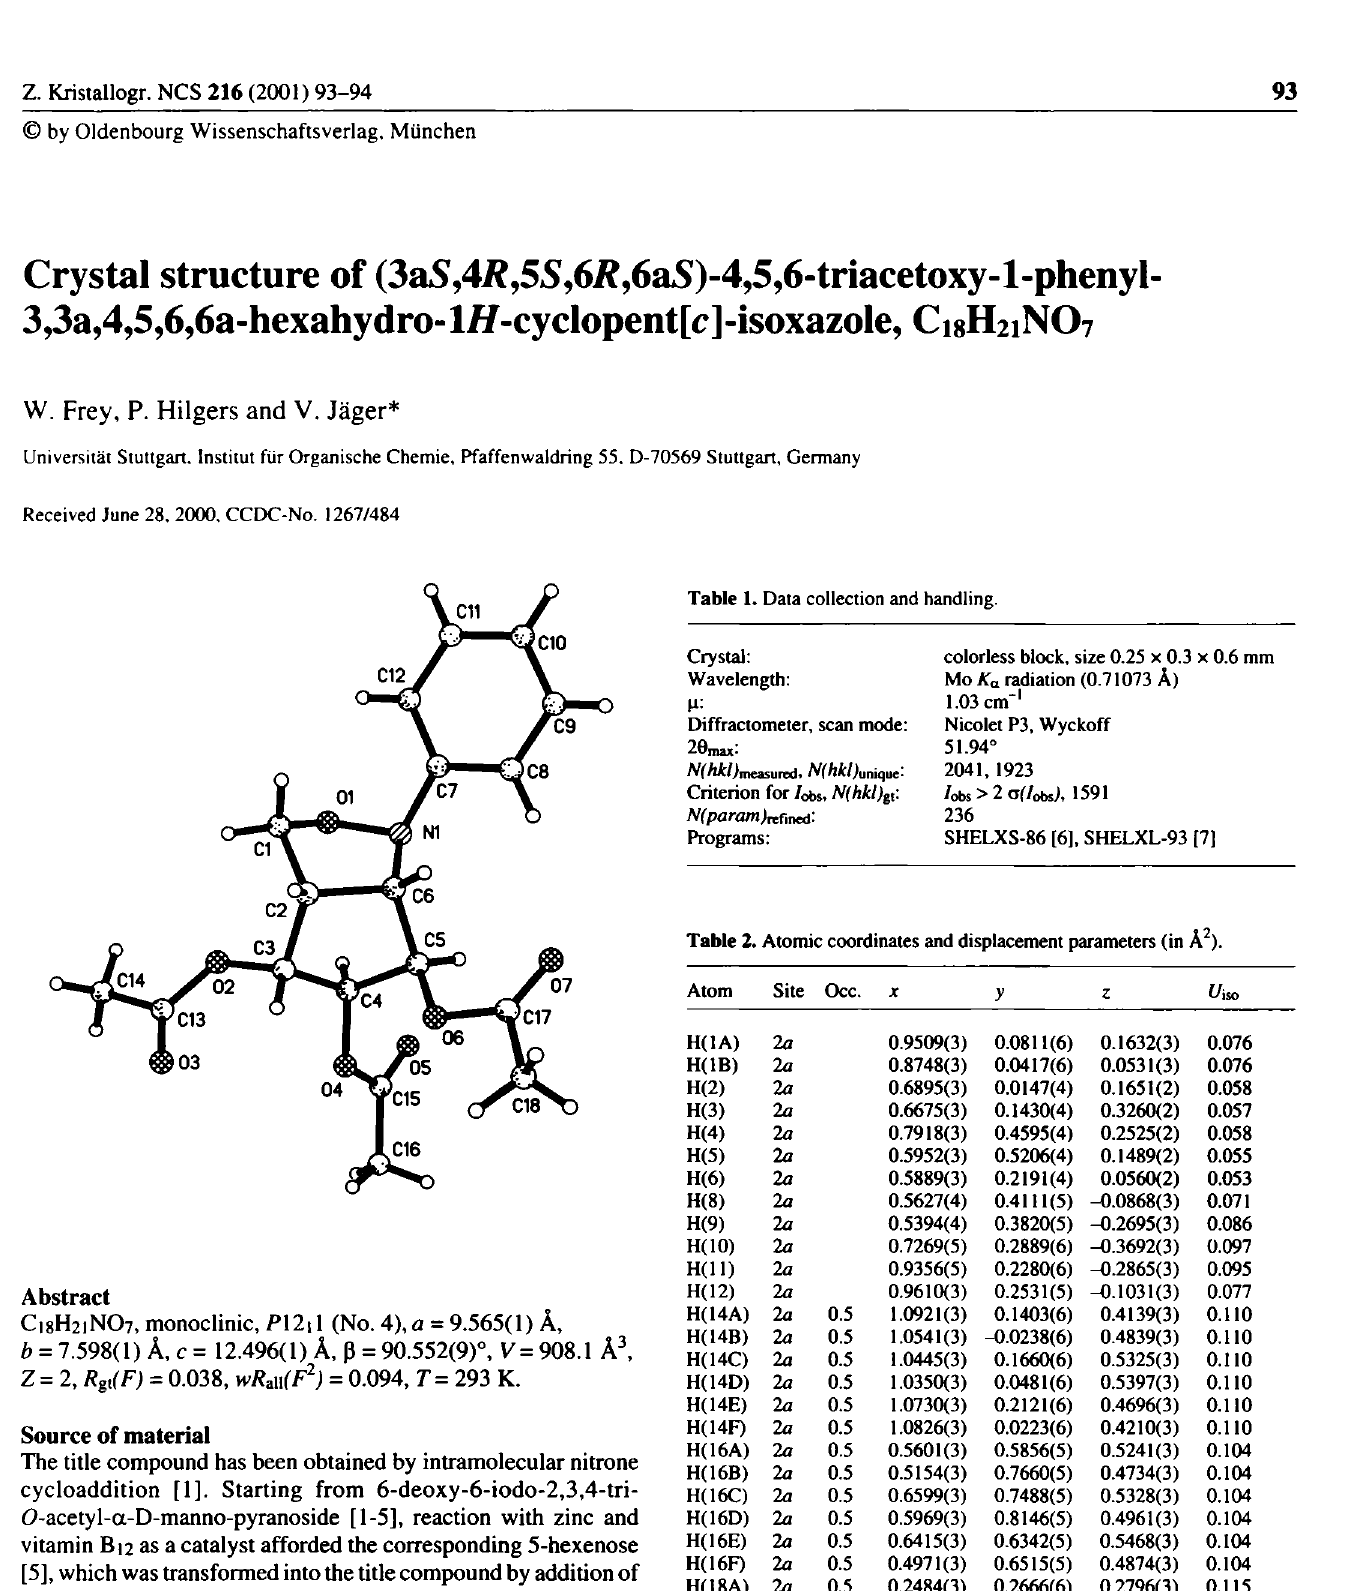
Table 2. Atomic coordinates and displacement parameters (in A 2